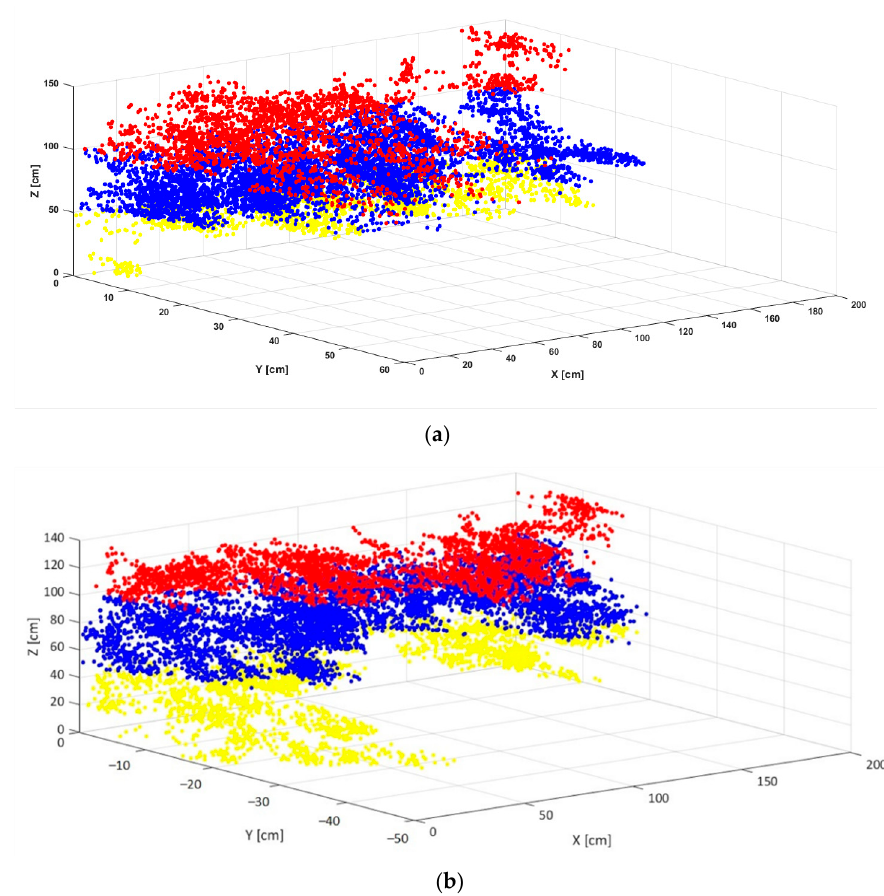
Figure 11. Reconstruction of the canopy from lidar measurement points. Segments of the same height are shown in different colors: ( a ) left side of the canopy, ( b ) right side of the canopy.